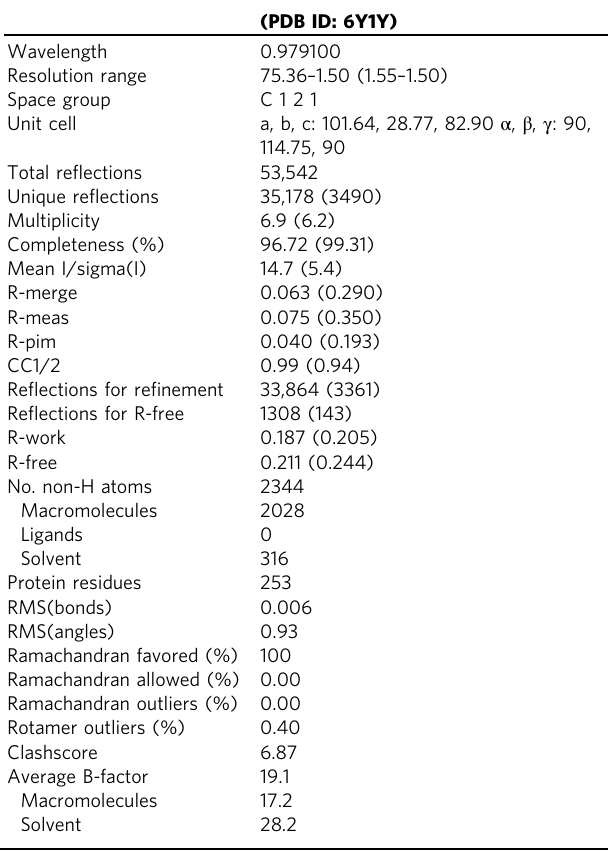
Table S3. To delete TDE1492 , the plasmid of TDE1492::ermB was transformed into Td wild-type competent cells via heat shock for 1min at 50 °C 34 . Erythromycin-